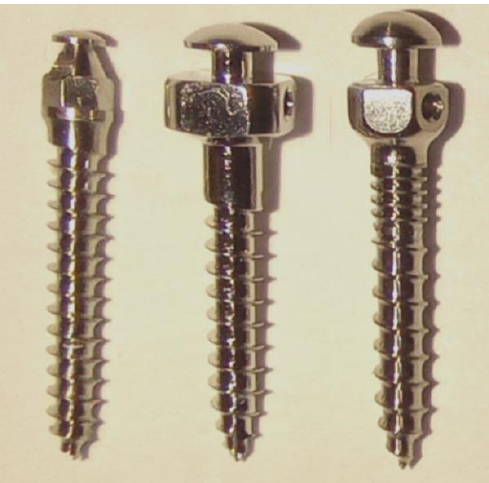
Figure 1. Microimplants manufactured with 3 designed types, from left to right: Type A. 5 × 10 mm; no microthread neck), Type B (1.5 × 10 mm; no microthread neck), and Type C (1.5 × 10 mm; microthread neck).